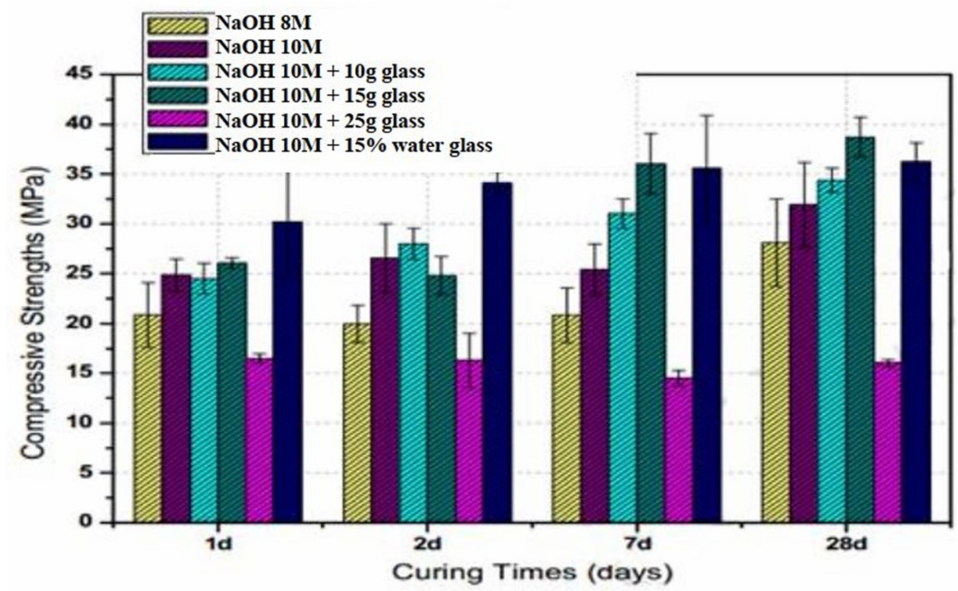
Figure 26. Effect of WG (particle size < 45 µ m) solution as an activator in fly ash-based geopolymer concretes